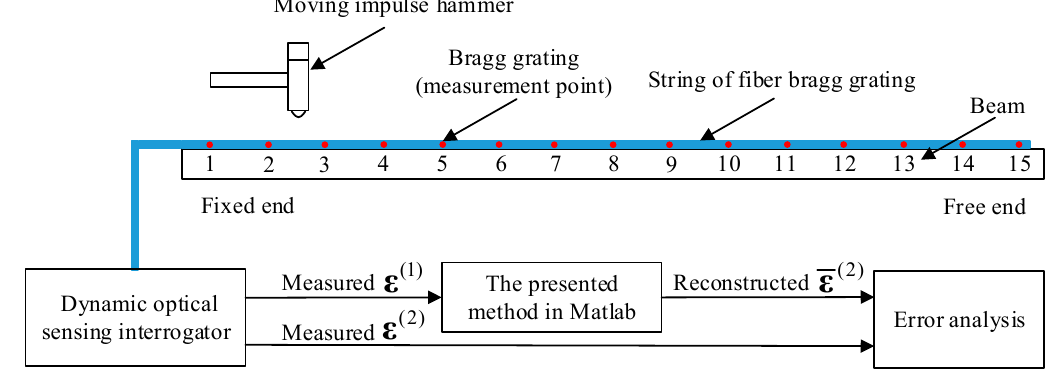
Figure 13. Schematic diagram of the experimental setup for the validation of the presented strain/stress reconstruction method. Table 3. Dimensions and properties of the aluminium alloy beam.